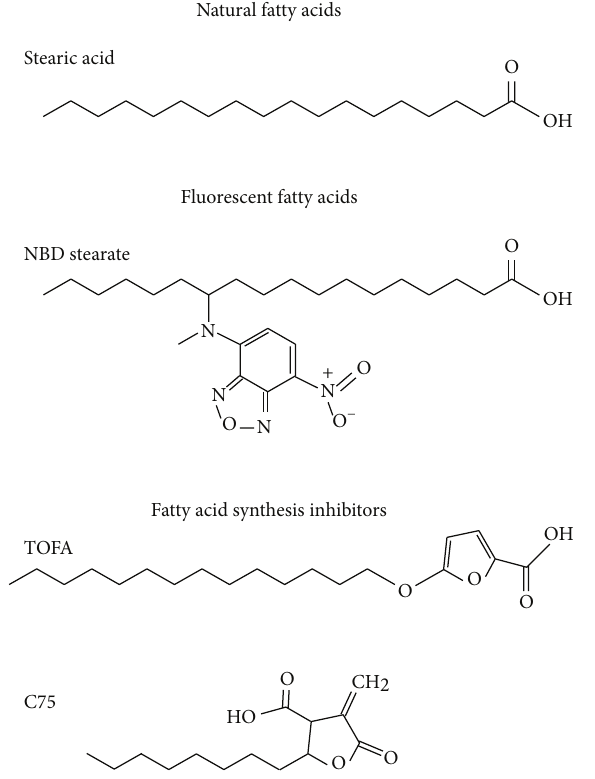
Figure 1: Structural comparisons of the fatty acid synthesis inhibitors TOFA and C75 with natural and fluorescent fatty